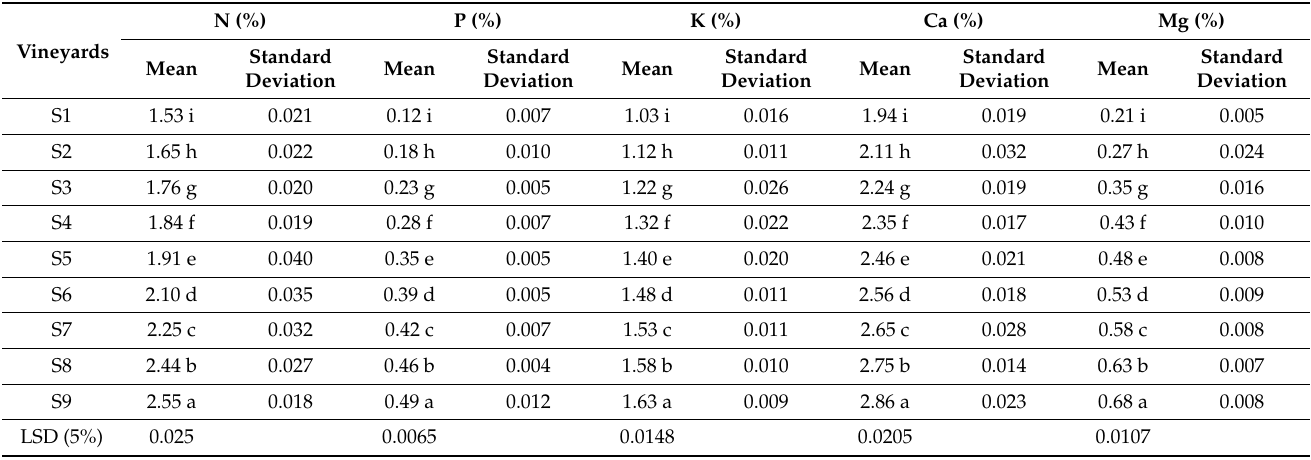
Table 3. Distribution of mean * values of Fe, Cu, Mn, and Zn in leaves petioles of Flame Seedless grape cultivated by different agricultural practices in investigated vineyards.